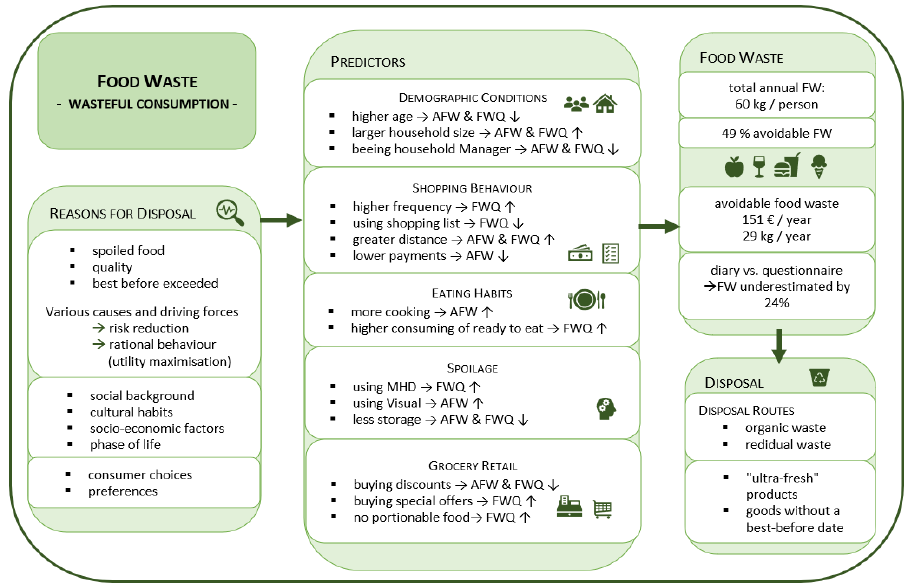
Figure 7. Influencing factors of food waste. Own illustration.